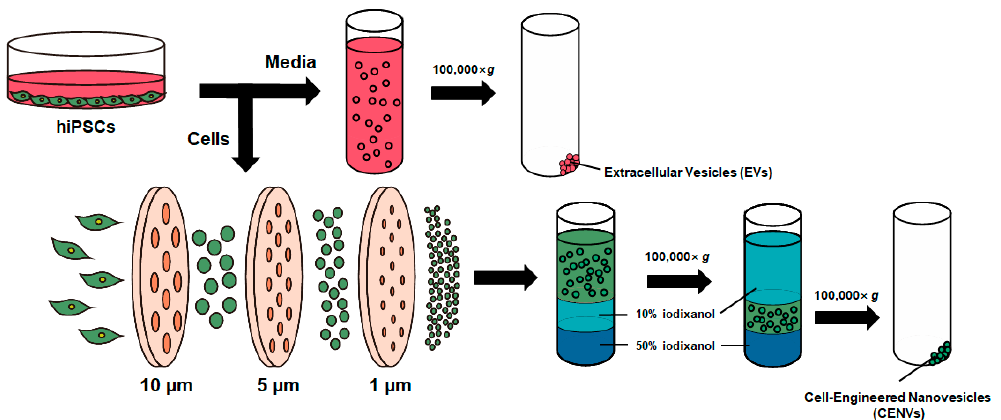
Figure 1. Schematic of the preparation of extracellular vesicles (EVs), and cell-engineered nanovesicles (CENVs) from human induced pluripotent stem cells (iPSCs). For iPSC-EVs preparation, spent medium conditioned by human iPSCs was collected, and subsequently ultracentrifuged for 2 h. For iPSC-CENVs preparation, cells were serially extruded through the polycarbonate membrane with diminishing pore size. Then, the generated iPSC-CENVs were collected by density-gradient ultracentrifugation using iodixanol (OptiPrep™).